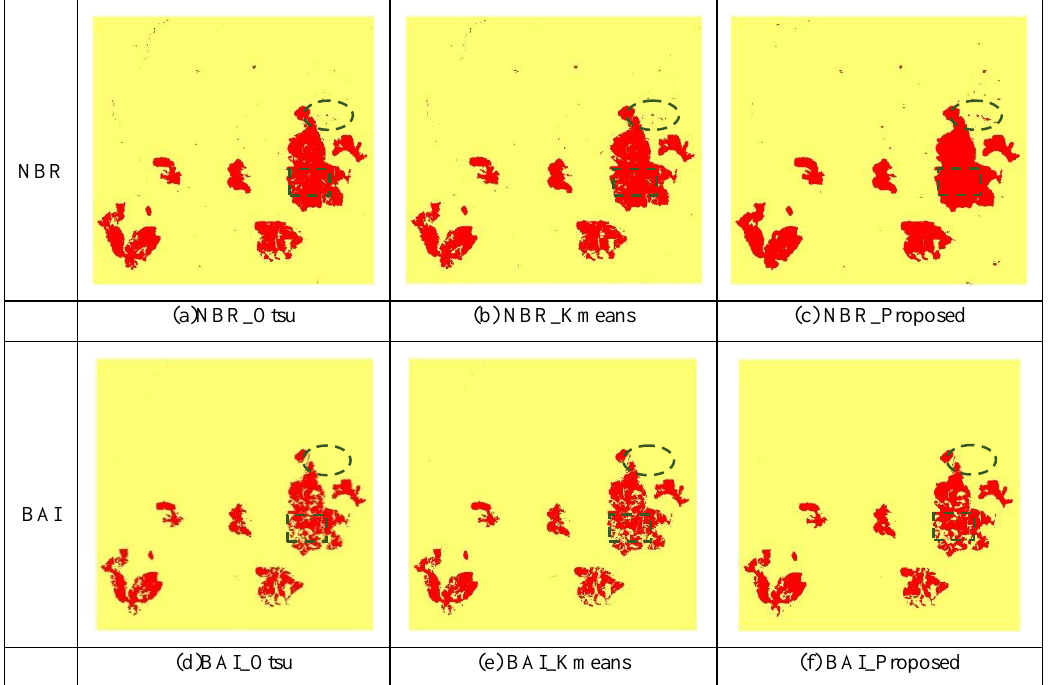
Figure 5. Burned area mapping results of different methods: (a)~(c): NBR-based burned area mapping results by Otsu, Kmeans and Proposed method; (d)~(f): BAI-based burned area mapping results by Otsu, Kmeans and Proposed method.